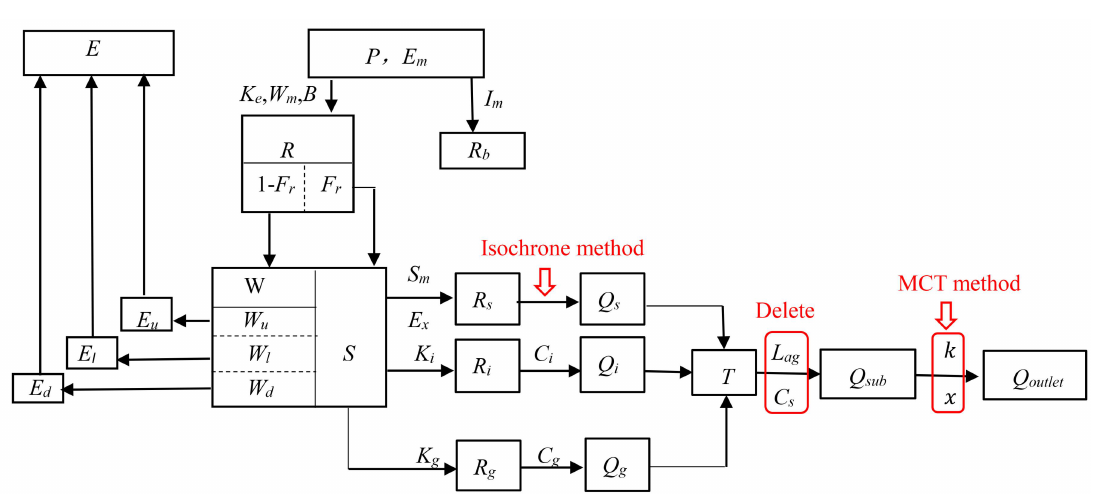
Figure 1. Structural chart of Xin’anjiang model and the new runoff routing scheme.